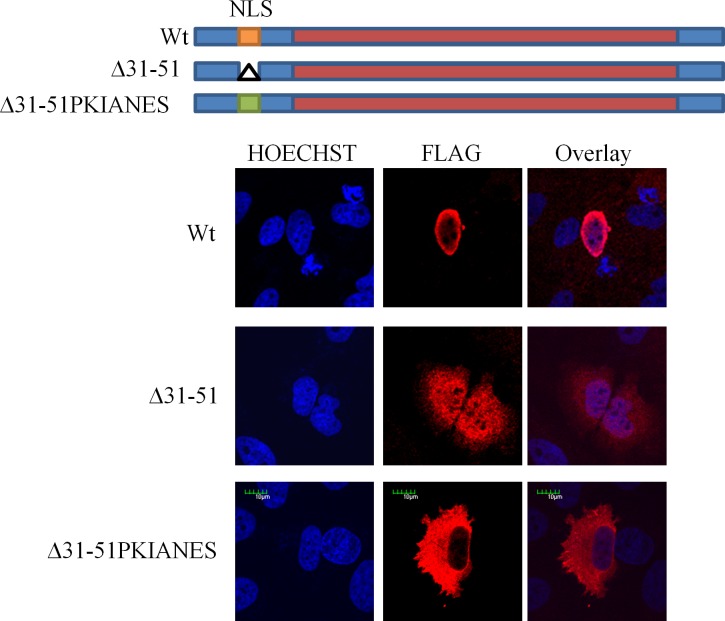
AA31-51 are required for nuclear localization of TRIB1.Top, schema of the deletions and insertions introduced in FLAG-tagged TRIB1. Bottom, immunofluorescence analysis of HeLa cells transfected for 48 h with the indicated TRIB1 mutants. FLAG tagged TRIB1 expressing cells were fixed, permeabilized and examined by confocal microscopy using an antibody specific for the FLAG epitope and an anti-mouse secondary (Alexa 647 goat anti-mouse, Molecular Probes). Nuclei were counterstained with Hoechst 33342.